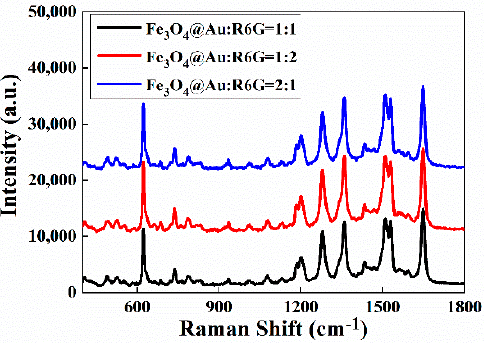
Figure 7. ( A ) SERS signals of R6G recorded from nine preparation batches of ITO/Au. ( B ) Storage stability check of R6G on ITO/Au and using Fe 3 O 4 @Au after 10 days.